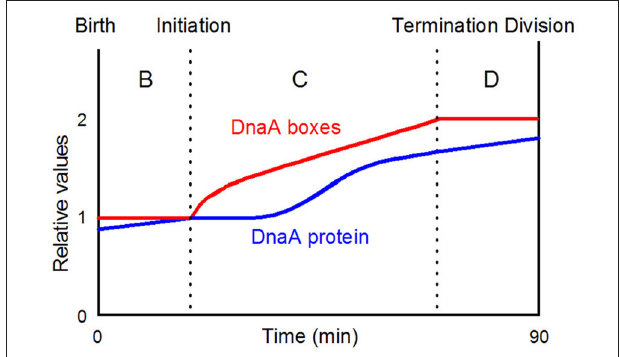
FIGURE 8 | A simplistic view of when initiation takes place in the cell cycle of slowly growing bacteria. The DnaA protein curve is drawn on the basis of the data presented by Theisen et al. (1993). DnaA-boxes with any distribution will be doubled during the C-period; the actual distribution of all consensus DnaA-boxes and selected groups of consensus boxes are presented in Figure 10 ; the figure is redrawn from Figure 2A in Herrick et al. (1996, Copyright, John Wiley and